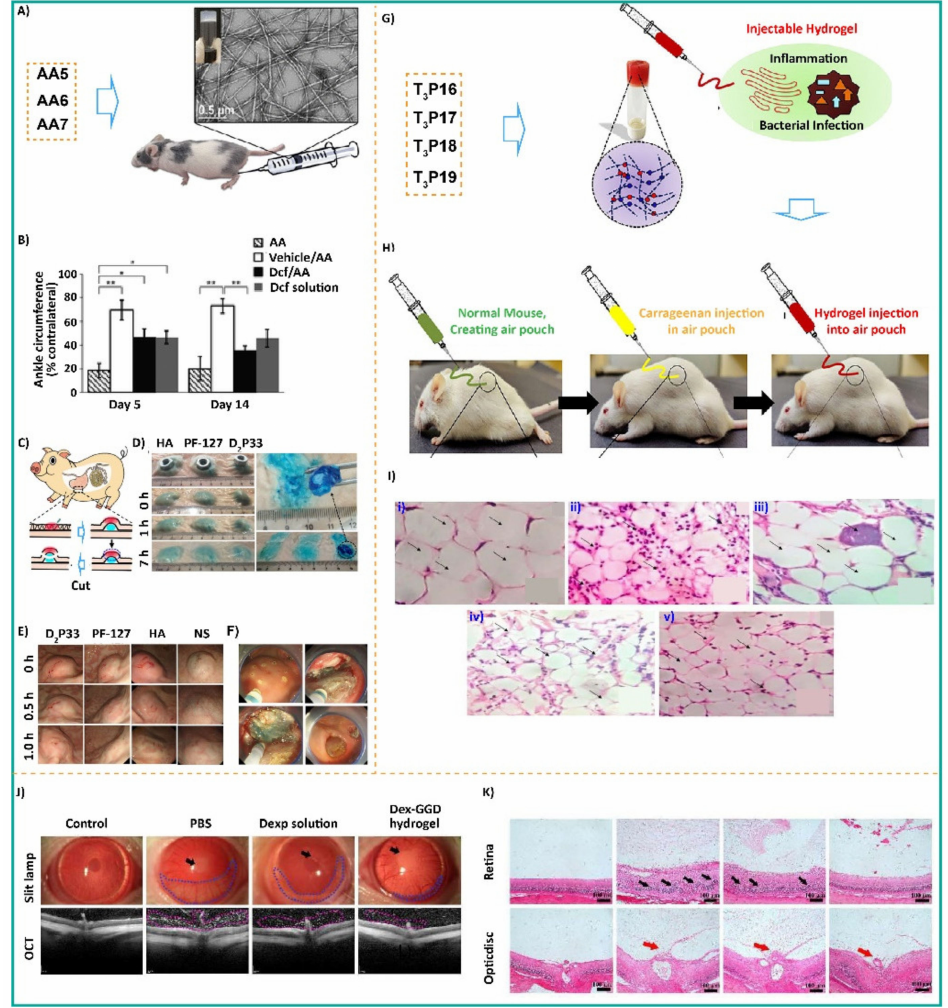
Figure 21. ( A ) Schematic illustration for injectable amino acid gel for in vivo experiment. ( B ) Ankle circumference graph of all four groups of mice with marked statistical differences; reproduced with permission from Ref. [53]. Copyright (2019) American Chemical Society. ( C ) ESD filler graphic of the D 2 P33 hydrogel. ( D ) Photographs of mucosal elevation of resected stomach altered over time at 37 ◦ C. ( E ) Photographs of endoscopic elevation of injected hydrogel in a living mini-pig’s stomach. ( F ) Post-injectable ESD procedure of D 2 P32 hydrogel; reproduced with permission from Ref. [84]. Copyright (2020) American Chemical Society. ( G , H ) Schematic illustration of injectable hydrogels for in vitro and in vivo applications. ( I ) Histopathological images of endothelial tissue: (i) normal rat; (ii) carrageenan treated; (iii) dichlorofenac sodium treated; (iv,v) after treating with the nanogels at lower (0.25%) and higher concentrations (0.5%), respectively.; reproduced with permission from Ref. [118]. Copyright (2021) American Chemical Society. ( J ) Slit-lamp and OCT images of EAU rats treated by intravitreal injection of PBS, Dexp solution, and Dex-GGD hydrogel at the 12th day after immunization (blue circle indicates hypopyon, and magenta circle indicates inflammatory cells infiltration). ( K ) Histological observation of the retina and optic disc from EAU rats treated by intravitreal injection of PBS, Dexp solution, and Dex-GGD hydrogel at the 15th day post-immunization (the black arrow indicates retinal folds, and the red arrow indicates inflammatory exudate); reproduced with permission from Ref. [119]. Copyright (2021)